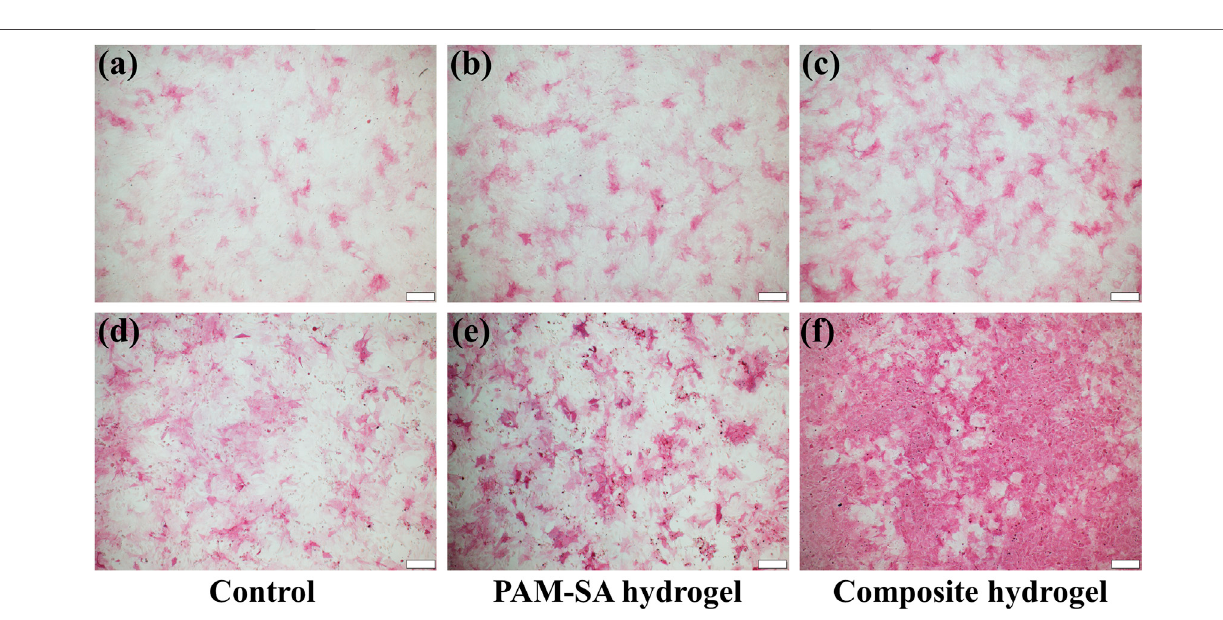
Frontiers in Materials |